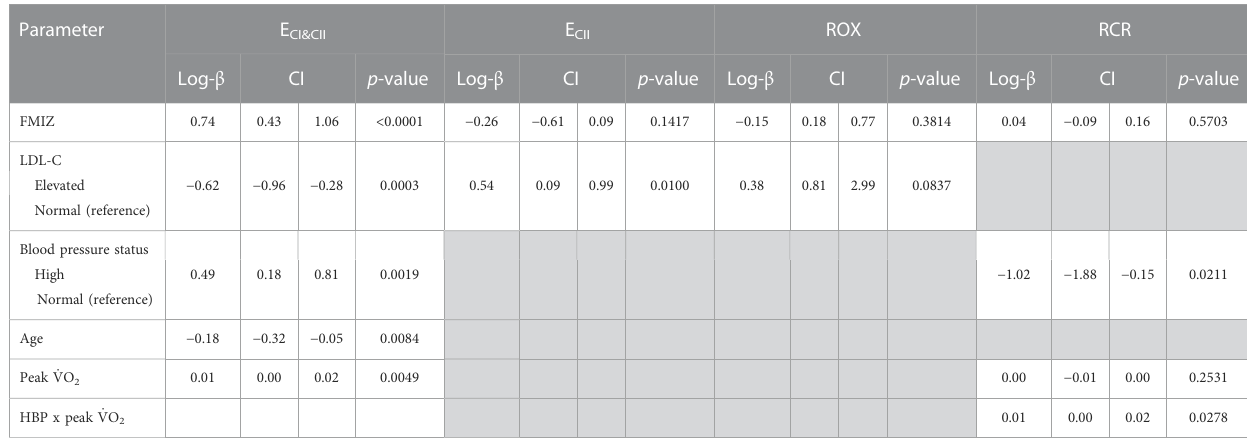
evaluating associations between PL and cardiac muscle